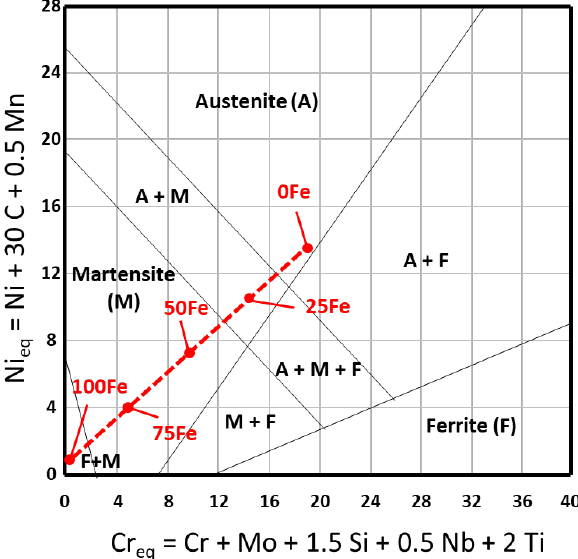
Figure 15. Schaeffler diagram representing the predicted phase of each composition.